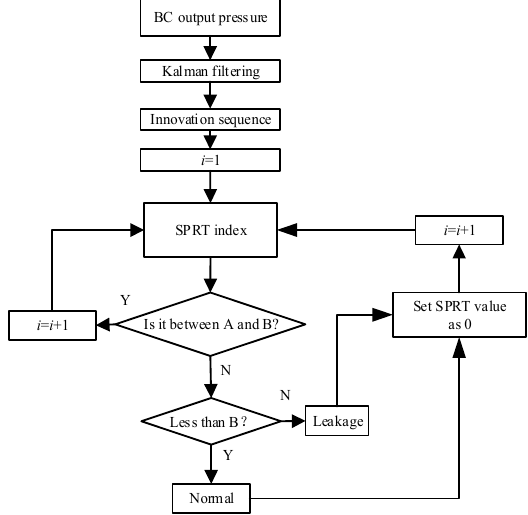
Figure 3. Leakage detection process based on the Kalman and sequential probability ratio test (SPRT) Method.